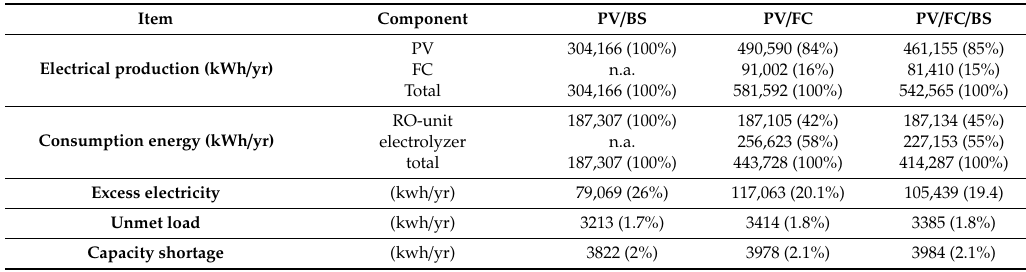
Table 5. Electrical energy production and